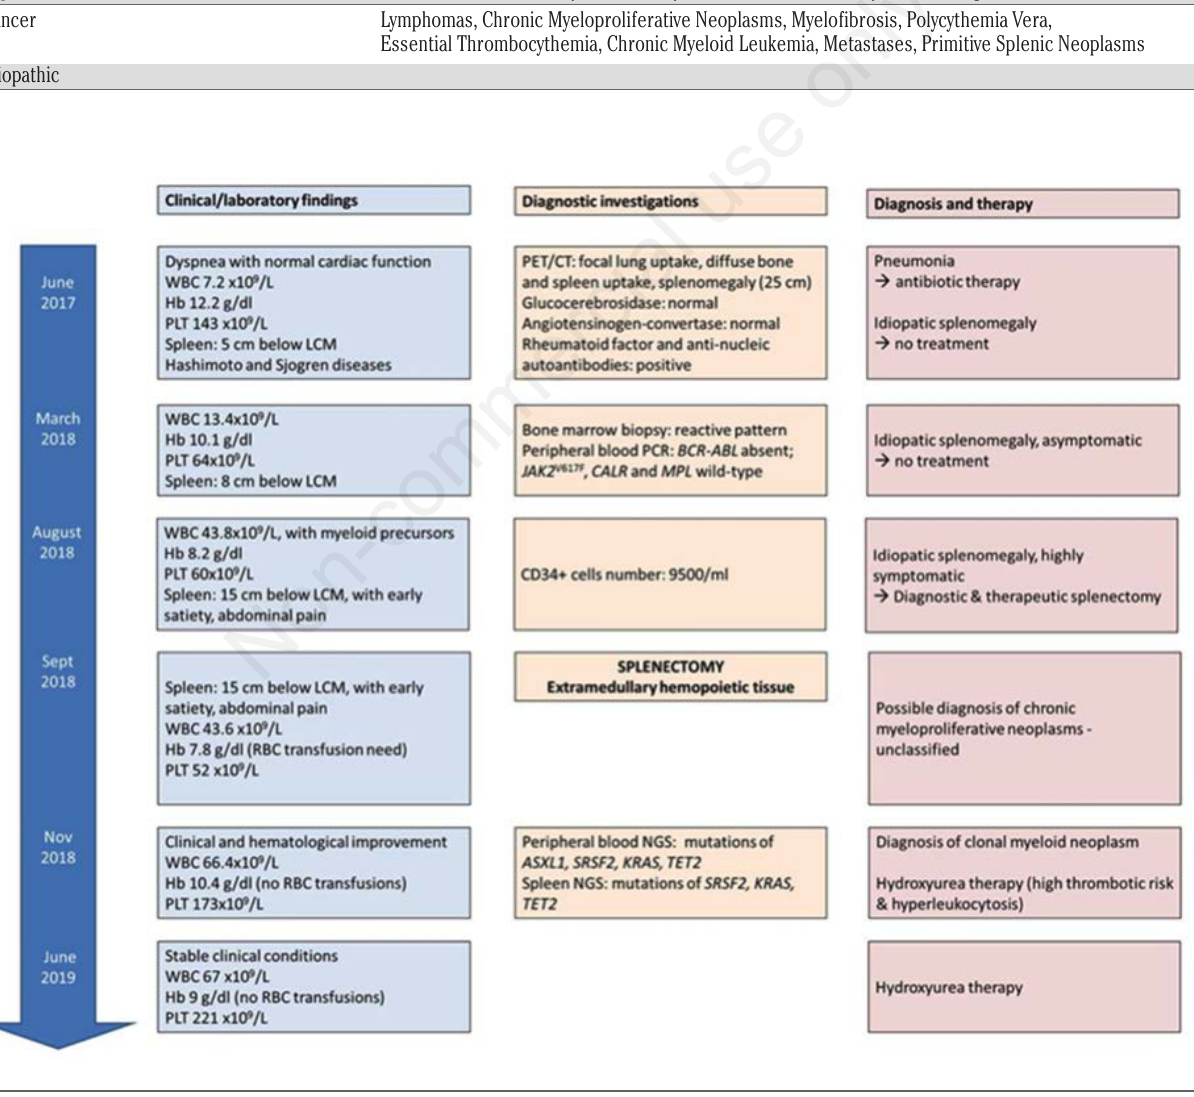
Figure 1. Case report timeline Clinical/laboratory findings (left), diagnostic investigations (center), diagnostic/therapeutic approach (right), and timing (arrow). WBCs: White blood cells; Hb: hemoglobin; PLT: platelets; LCM: left costal margin; RBCs: red blood cells; PCR: polymerase chain